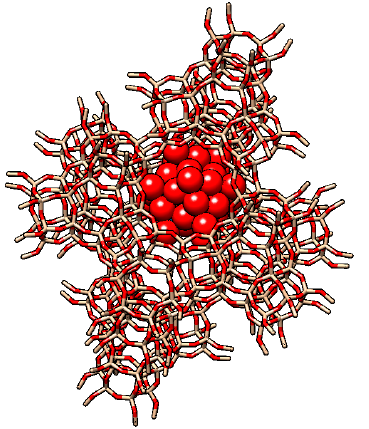
Figure 2. Keggin polyoxometalate in the supercage of Y zeolite (red: oxygen, yellow: silicon or aluminium).